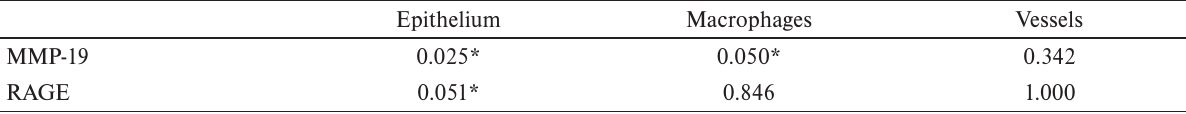
Table 2. Expression of MMP-19 and RAGE. Compared CRC group to controls.